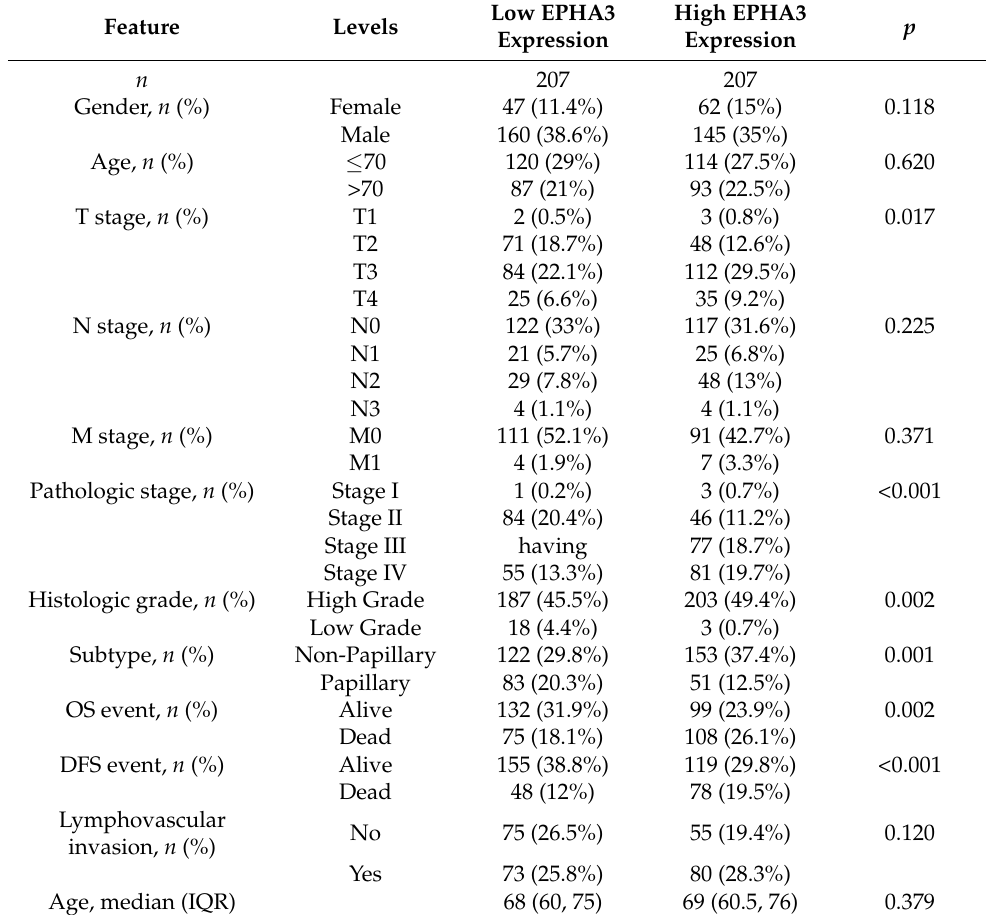
Table 1. Clinicopathological features of TCGA-BLCA